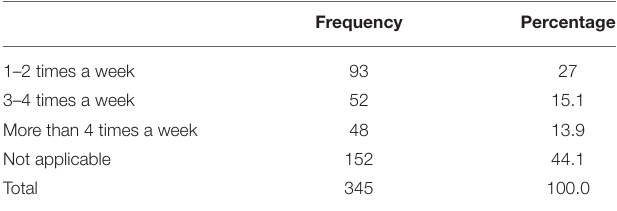
TABLE 14 | Access to software that students